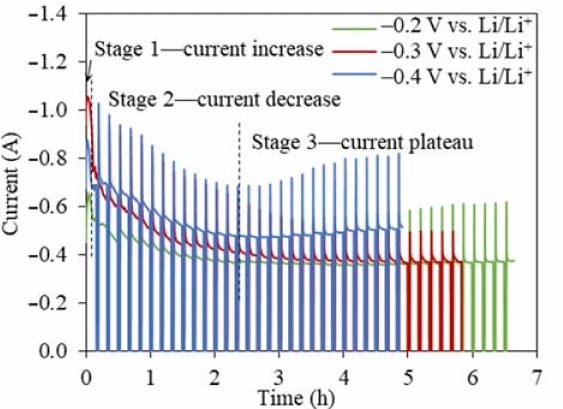
Figure 3. Current–time profiles for the 2 g TiO 2 reductions at cathodic reduction potentials of − 0.2 V, − 0.3 V, and − 0.4 V vs. Li/Li + with intervals using 80% of the theoretical